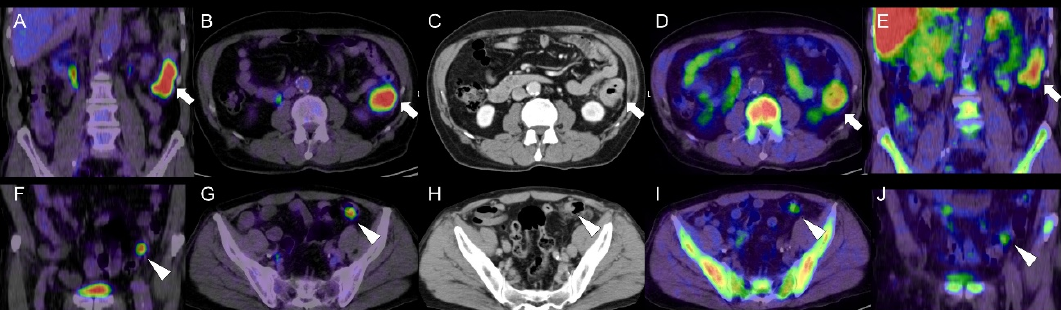
Figure 1. A 70-year-old man with pathologically proven adenocarcinoma in the descending colon and moderate to severe type tubular adenoma in the sigmoid colon. An adenocarcinoma is seen in the descending colon on ( A ) coronal- and ( B ) axial-fused FDG PET/CT imaging (arrows); ( C ) contrast-enhanced CT (arrow); and ( D ) axial- and ( E ) coronal-fused 4DST PET/CT imaging (arrows). The colon adenoma is seen on ( F ) coronal- and ( G ) axial-fused FDG PET/CT (arrowheads); ( H ) contrast-enhanced CT (arrowhead); and ( J ) axial- and ( I ) coronal-fused 4DST PET/CT imaging (arrowheads). FDG PET/CT revealed high FDG uptake (SUV max 15.2) in the advanced CRC at the descending colon, and the lesion was also confirmed with high 4DST uptake (SUV max 4.8). We found that tubular adenoma could be visualized by 4DST-PET/CT (SUV max 2.5) as well as by FDG (SUV max 7.7).